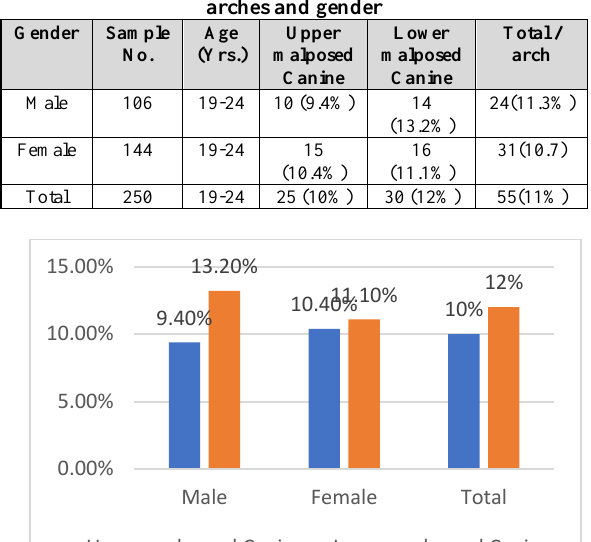
Figure 1: Distribution of malposed canines in both arches and gender